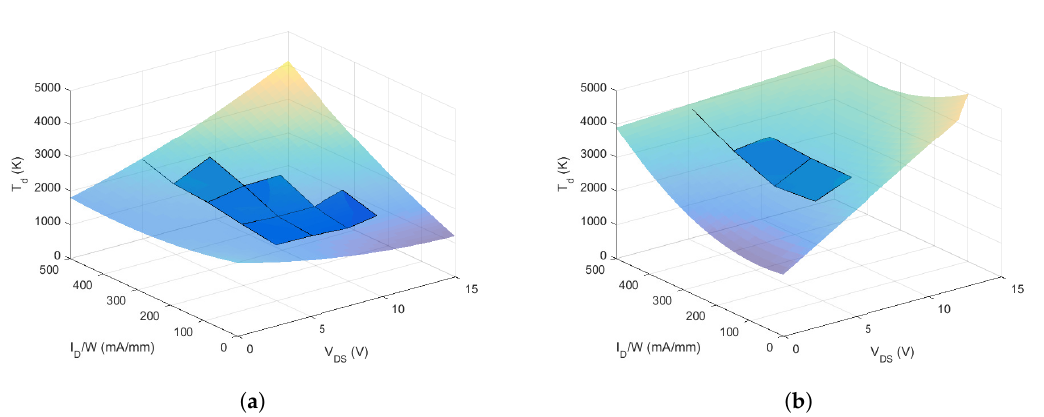
Figure 9. Noise temperature extraction and fitting for 4x050 devices. The vertices of the opaque patches represent actual extraction points. The transparent surfaces represent the polynomial fittings: ( a ) D01GH. ( b ) D006GH.